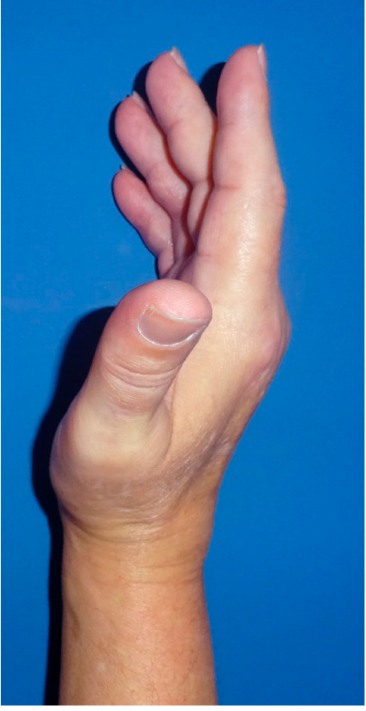
Figure 9. Presented patient 8 weeks after